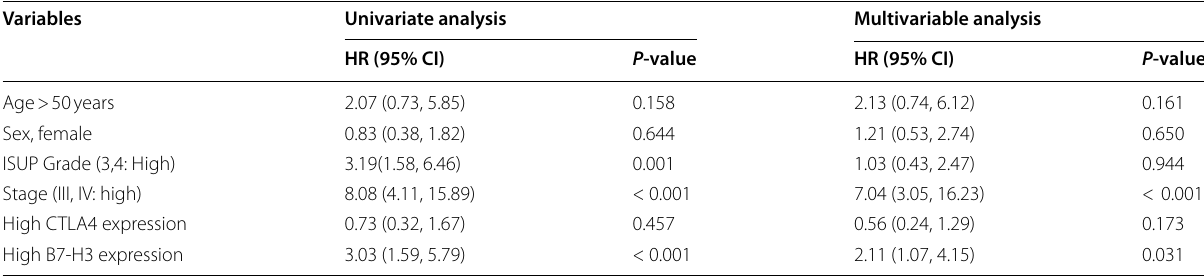
Table 3 Analysis of prognostic factors for survival